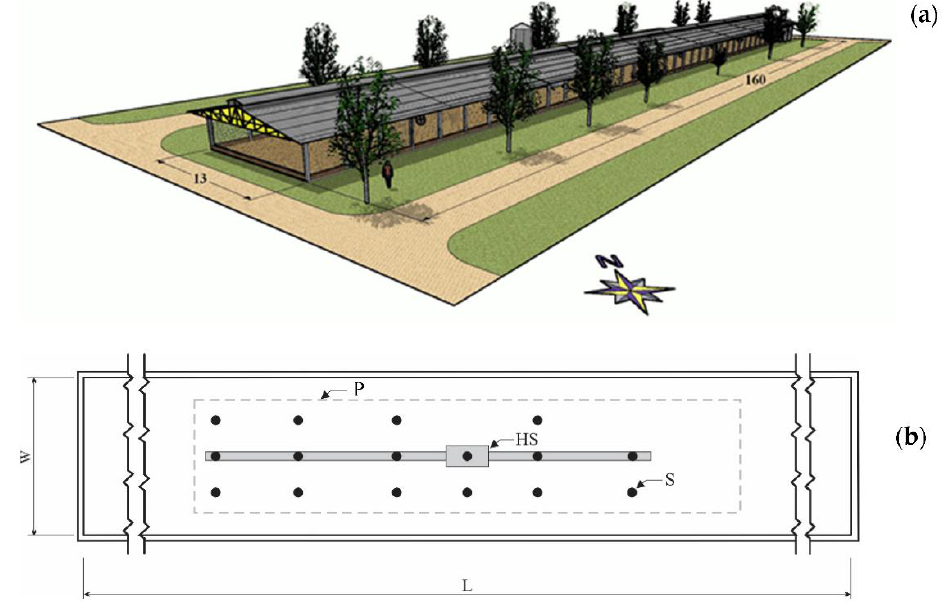
Figure 1. ( a ) Diagram of the broiler house evaluated in this study, indicating the main dimensions in meters. ( b ) Scheme of the position of sensors/recorders of air temperature, where W is the width of the area available for the broiler chicks and L is the length, HS is the heater system, and P is the plywood sheet.